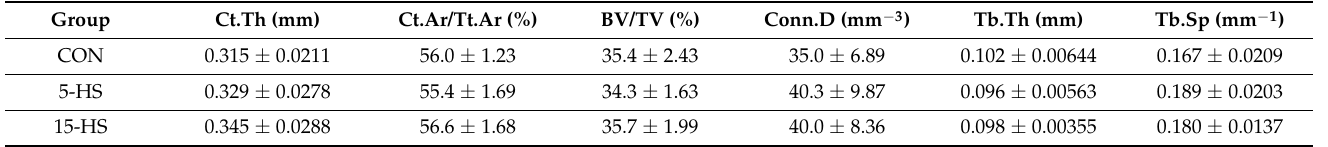
Table 3. Micro-architectural parameters of right femur cortical bone (Ct.Th & Ct.Ar/Tt.Ar) and L5